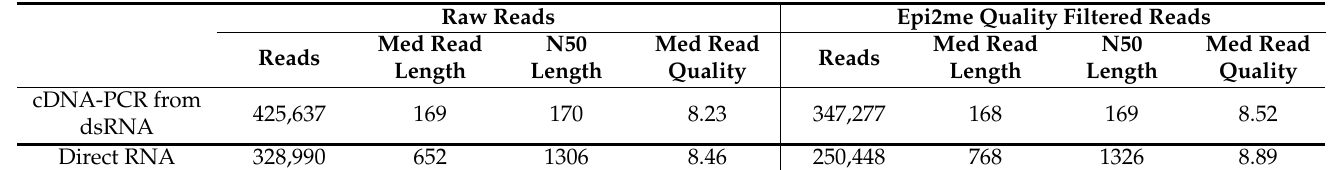
Table 1. Nanopore sequencing (MinION, Oxford Nanopore) results of the barcoded cDNA-PCR library from dsRNA and direct RNA, before and after Epi2me quality